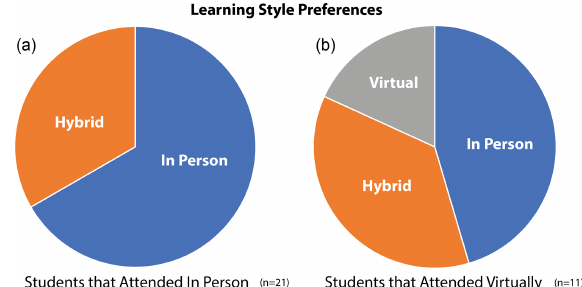
Figure 5. Charts of learning style preferences from student sur- vey; (a) learning style preferences from students that attended SST classes and field trips in person, with no preferences for virtual learning style indicated; (b) learning style preferences from students that attended SST classes and field trips virtually, with a greater preference for hybrid and virtual learning styles.